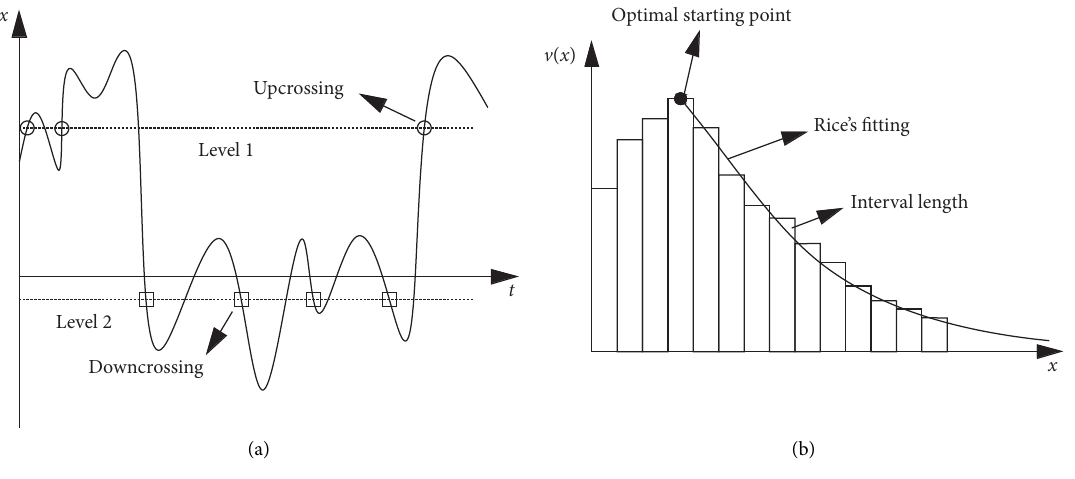
Figure 2: The level-crossing